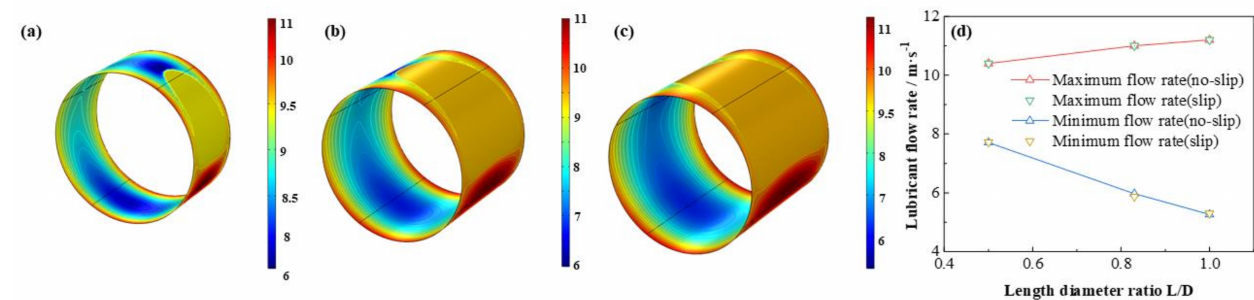
Figure 15. Comparison of the flow rate distribution under different length diameter ratios. ( a ) L / D = 0.5; ( b ) L / D = 0.83; ( c ) L / D = 1.0; ( d ) maximum/minimum flow rate.